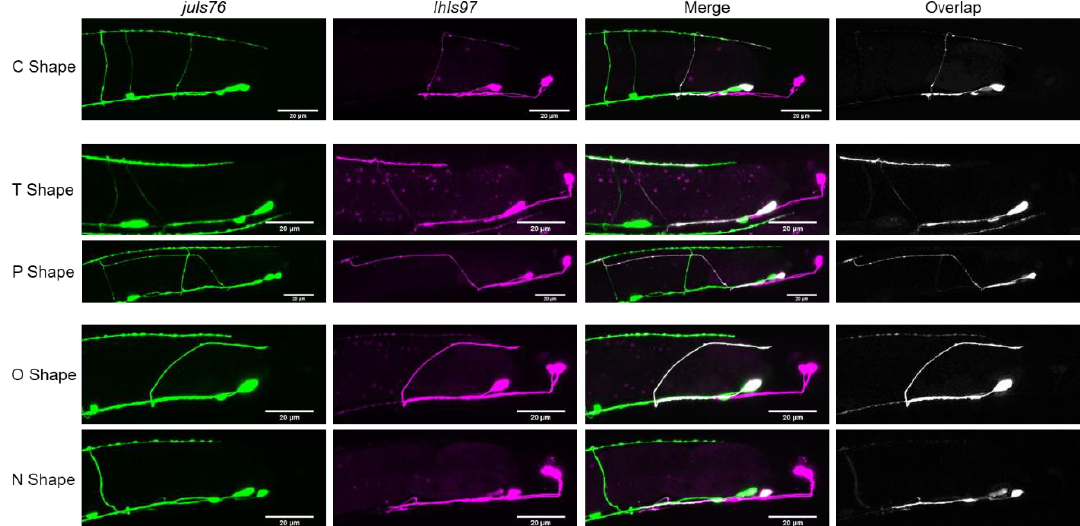
Figure 2. Different VD13 morphologies observed. The most common shape of VD13 in juIs76; lhIs97 animals was a C shape. Aberrant morphology categories observed were either in the dorsal cord polarity (“T” or “P” shaped) or commissural outgrowth and guidance (“O” or “N” shaped). Note, the “C”, “T”, and “O” shaped morphology examples are wild-type animals, “N” shaped, dsh-1 mutants, and “P” shaped from egl-20 mutants.